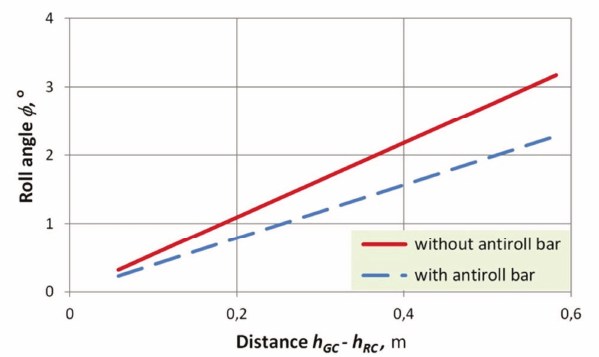
Fig. 7. Impact at vehicle roll angle of distance from centre of gravity to the roll centre (for a full-size vehicle) [own research]